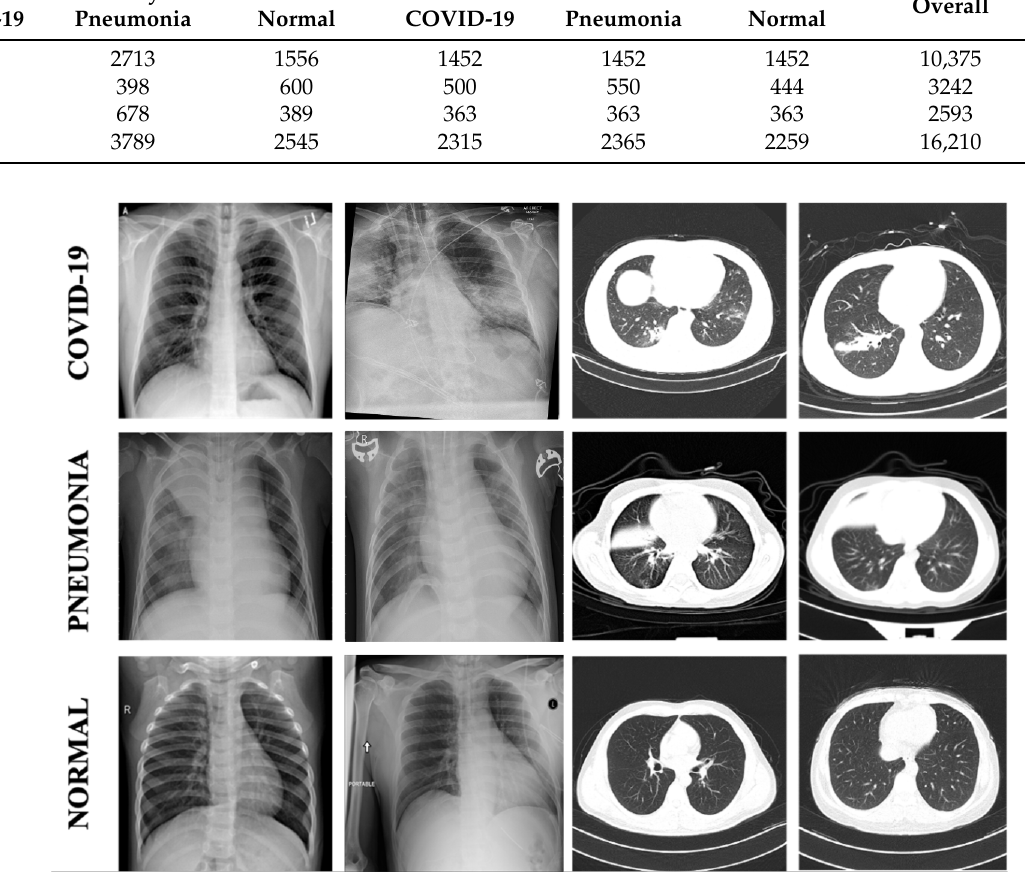
Figure 2. Example X-ray and CT images of COVID-19, Pneumonia, and Normal